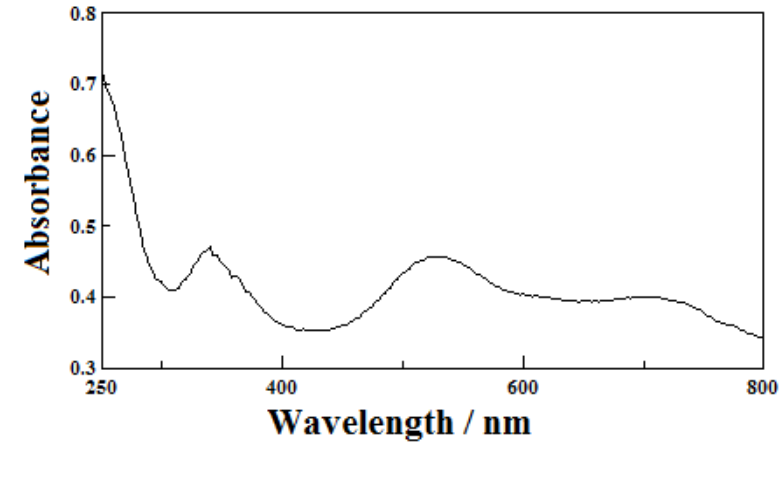
Figure 3. Solid state electronic absorption spectrum of [Ni(L)(H-cpdc  ) reflectance method at 20.0 ± 0.1